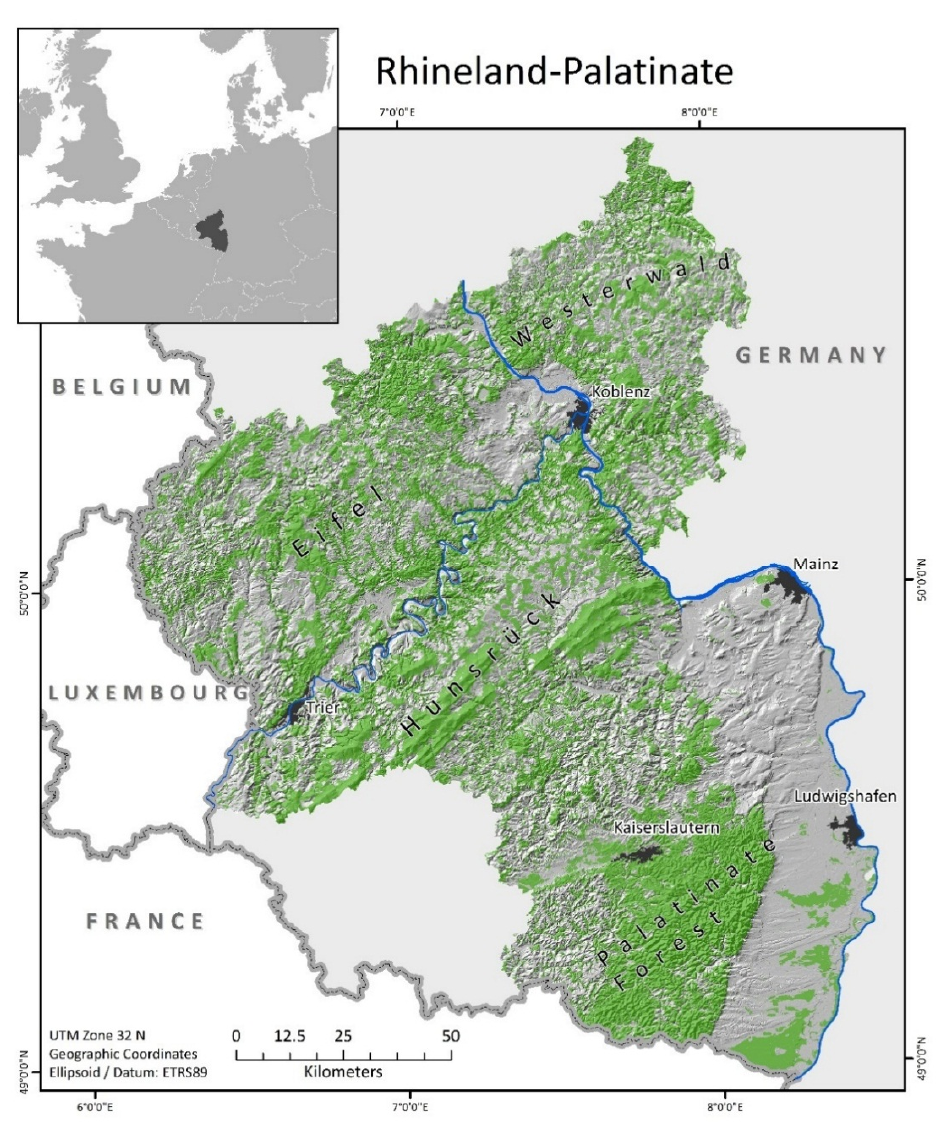
Figure 1. Study area: Detailed map of the study area highlighting the spatial distribution of forested areas